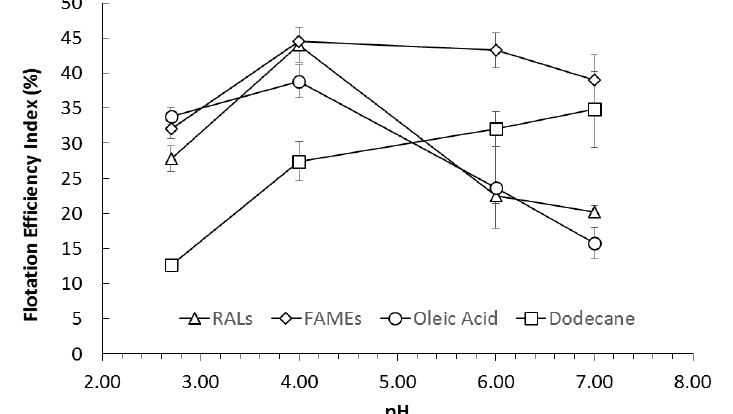
Figure 6. FEI as a function of pH for RALs, FAMEs, oleic acid, and dodecane collectors at a fixed dosage of 2.79 kg/t.